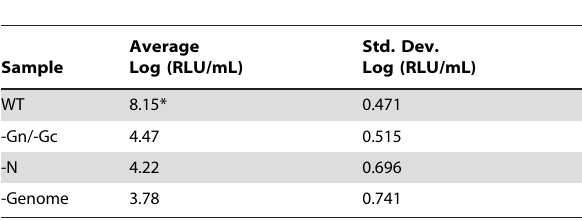
Table 4. Encapsidated genome required for infectivity.